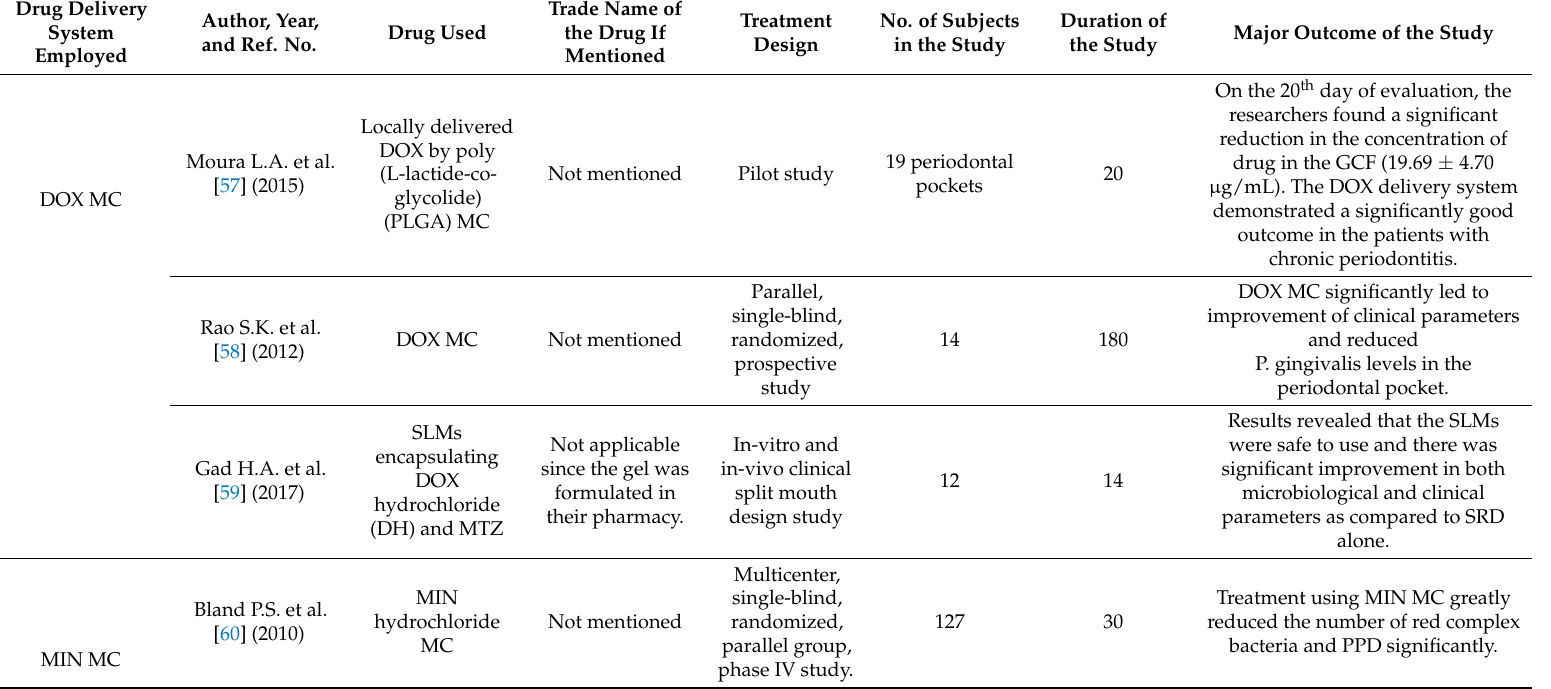
Table 4. Studies demonstrating use of microparticulate system in the management of periodontal disease in the past 10 years. Drug Delivery